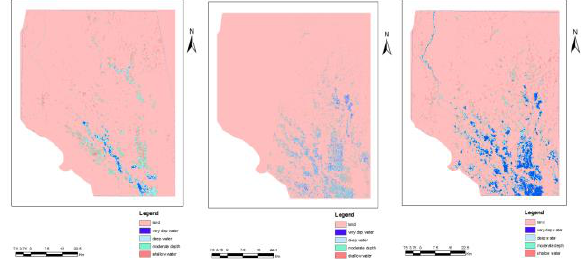
Fig. 3.5: Flood inundation area as derived from SAR data of 2002